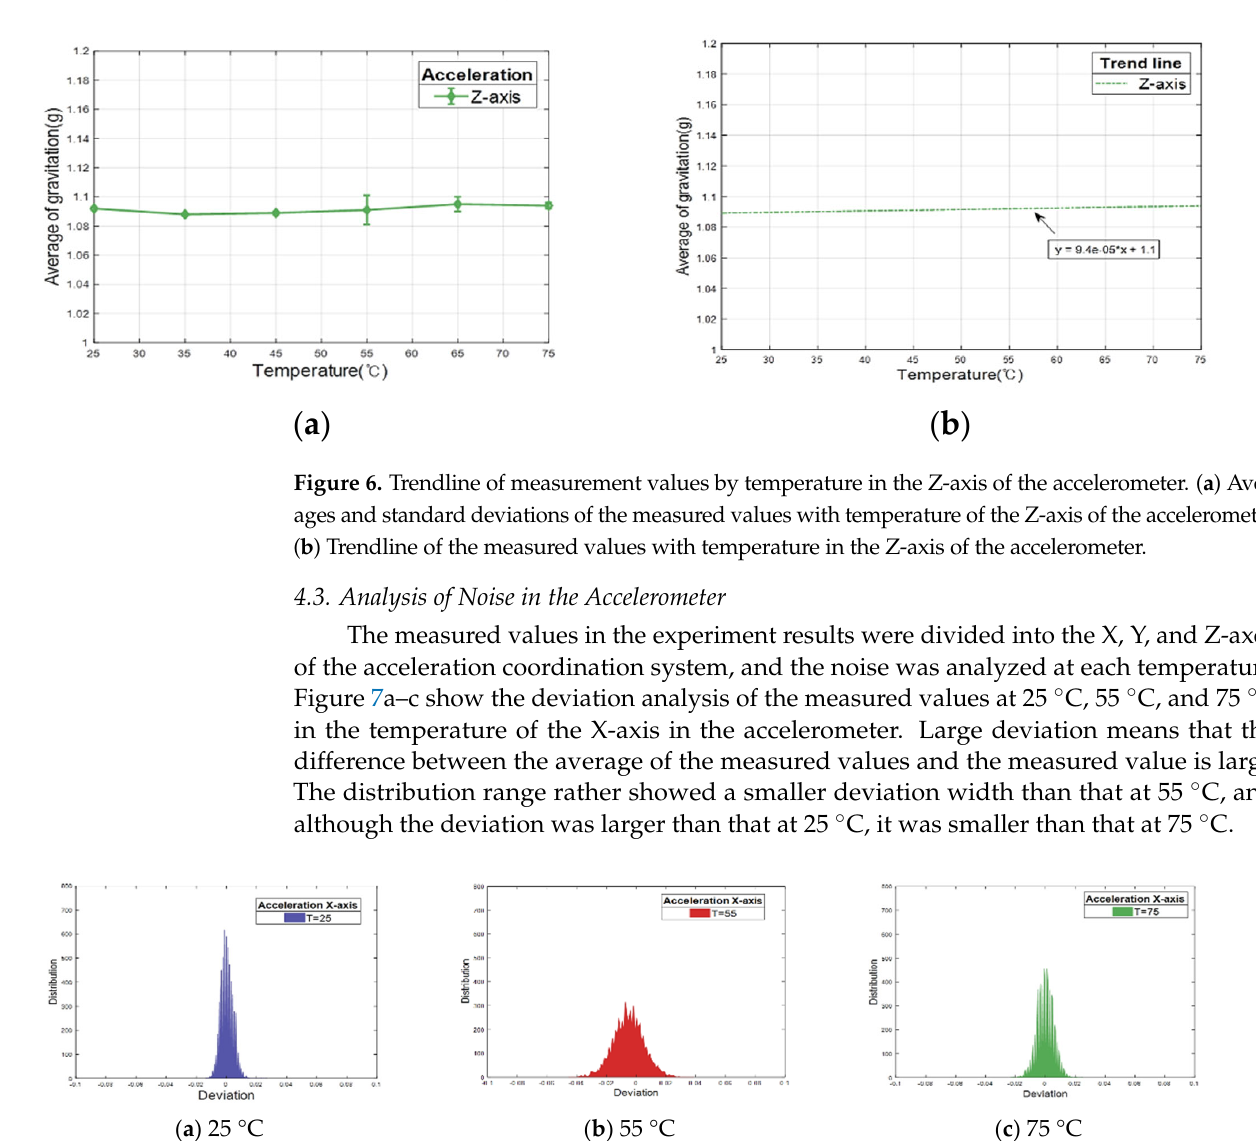
( c ) 75 °C Figure 8. Noise distribution chart of the Y ‐ axis of the accelerometer. Figures 9a–c shows the deviation analysis of the measured values at temperatures 25 °C, 55 °C, and 75 °C in the Z ‐ axis of the accelerometer. The distribution of average values was larger than that at 55 °C, but the deviation range was larger. ( a ) 25 °C ( c ) 75 °C Figure 9. Noise distribution chart of the Z ‐ axis of the accelerometer. 4.4. Analysis by Temperature in the G y roscope Sensor To analyze the measured values and standard deviations by the temperature of the gyroscope sensor, Figure 10 shows the measured values of the X ‐ , Y ‐ , and Z ‐ axes in the gyroscope sensor. Figure 11 shows the graph that displays the analysis of the trend line of the measured values. The trend of changes in the average values according to temperature rise showed that the gyroscope sensor’s X ‐ and Y ‐ axes exhibited a linear characteristic